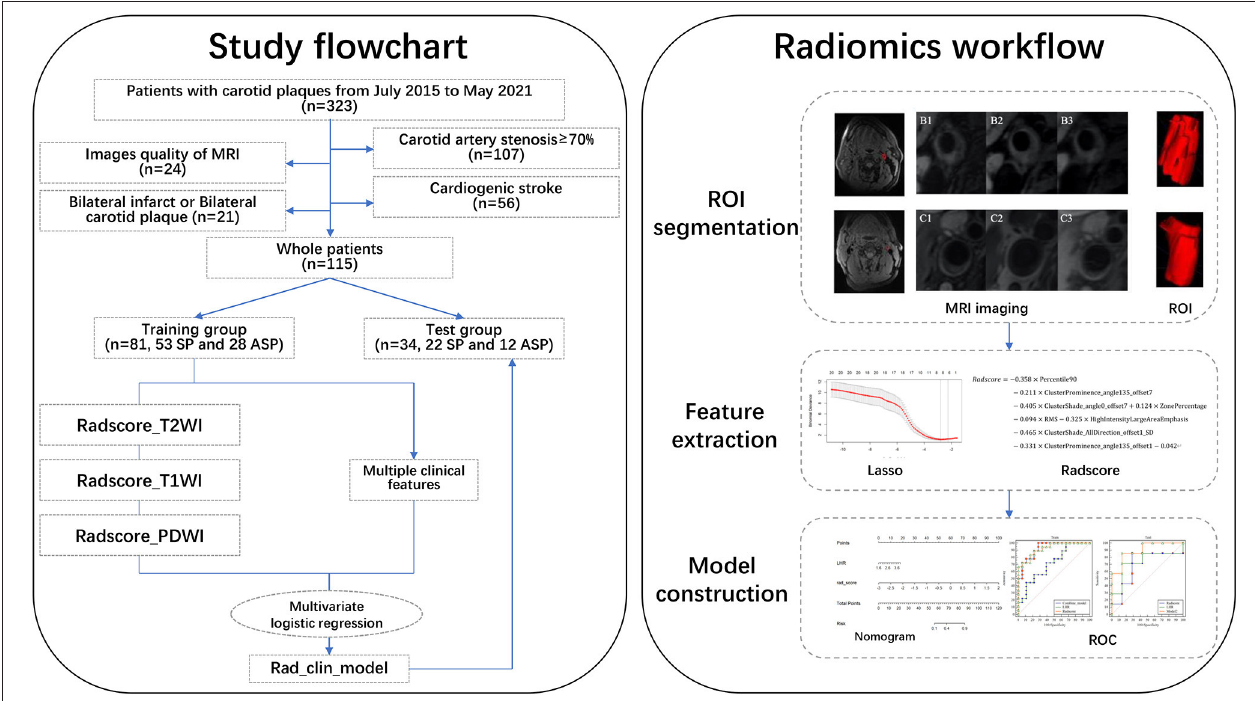
FIGURE 1 | Study flowchart and Raidomics